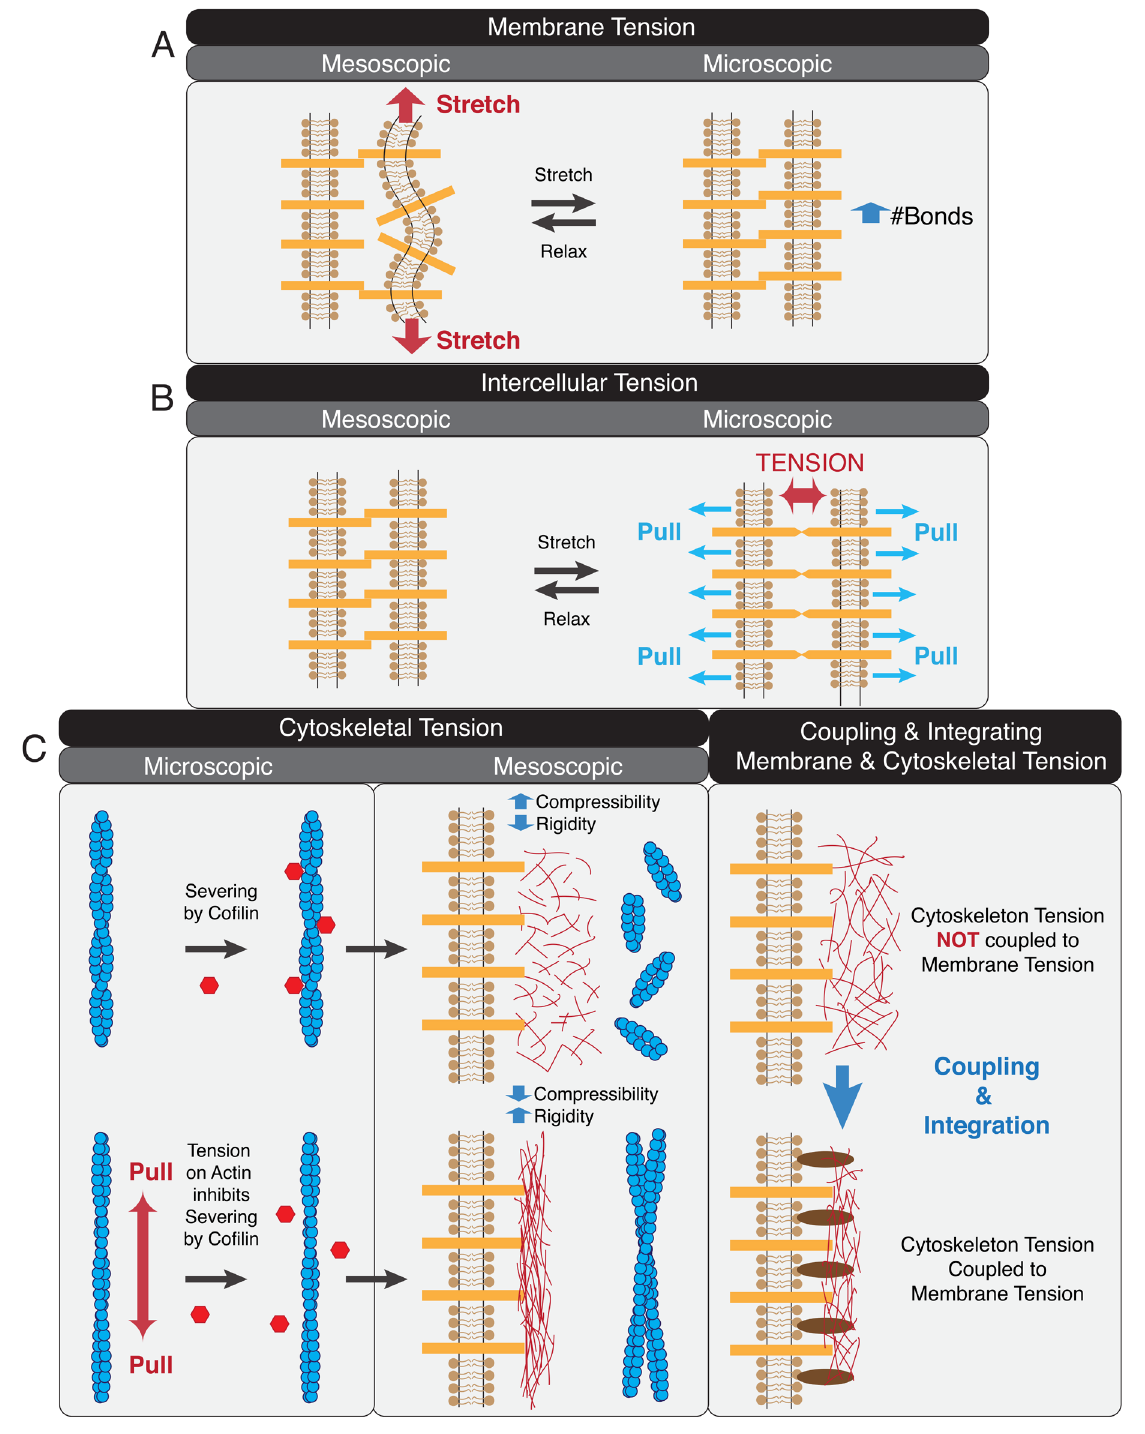
Figure 4. Pushing and pulling to create tension. ( A ) Stretching the membrane increases membrane tension at the mesoscopic lateral membrane level and can enhance intercellular interactions at the microscopic molecular level. ( B ) Pulling orthogonal to the membrane increases intercellular tension on the mesoscopic lateral membrane level and can enhance tension at cell–cell adhesion molecules at the microscopic molecular level. ( C ) Pulling actin filament alters actin dynamics and decreases cofilin severing at the microscopic molecular level (left panel). Changing the length distribution and organization of actin filaments alters cytoskeletal tension, ultimately affecting the compressibility and rigidity of cortical actin associated with the lateral membrane at the mesoscopic lateral membrane level (middle panel). Coupling membrane and cytoskeleton tension to adhesion proteins allows integration of intercellular, membrane, cytoskeletal forces on the lateral cell–cell adhesion interface (right